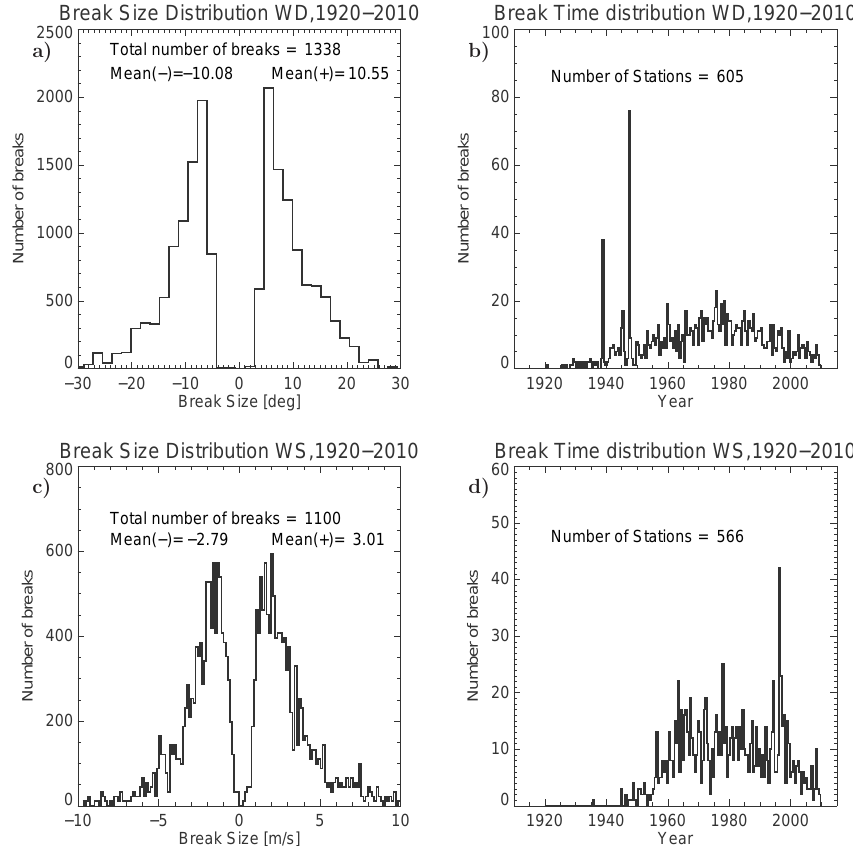
Figure 16. (a) Wind direction break size and (b) time distributions for the whole period investigated (1900–2010), for all available stations. Figure 16: (a) Wind direction break size and b) time distributions for the whole period (c) shows corresponding wind speed break size and (d) break time investigated (1900-2010), for all available stations. c) shows corresponding wind speed